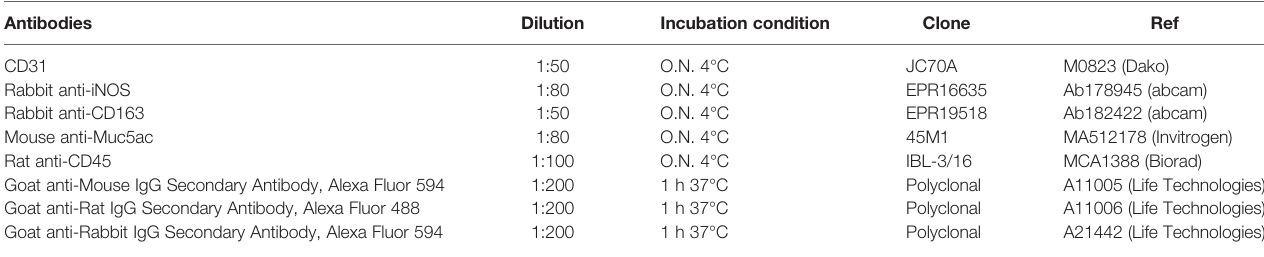
TABLE 2 | Antibody list. Antibodies